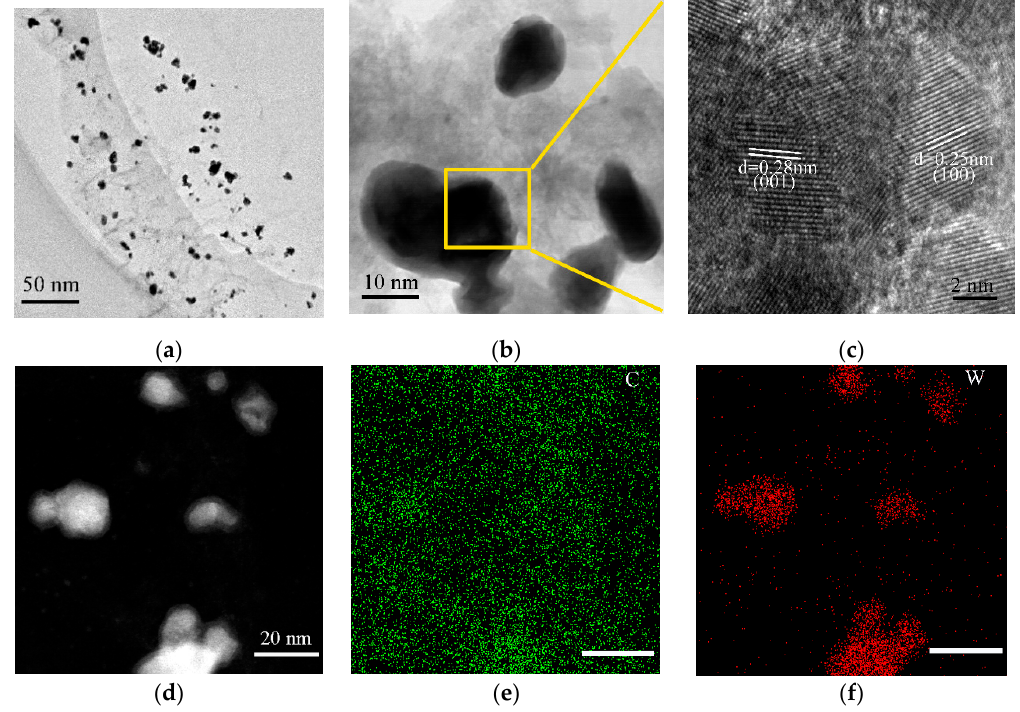
Figure 2. ( a,b ) Different magnification TEM images, ( c ) high-resolution TEM image, ( d ) high-angle annular dark-field (HAADF) image, and (e, f ) EDXS mapping images of W and C in 4 AMT.